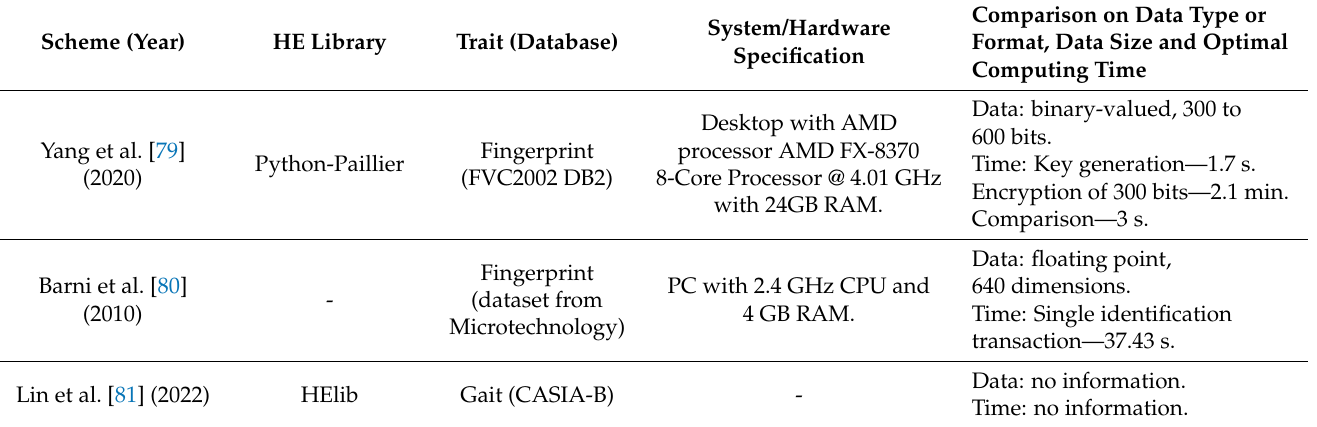
Table 4. Comparison of HE-based approaches to fingerprint security and gait security in terms of computational